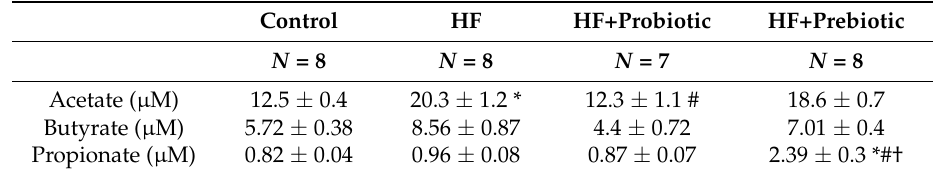
Table 3. Plasma levels of acetate, butyrate, and propionate